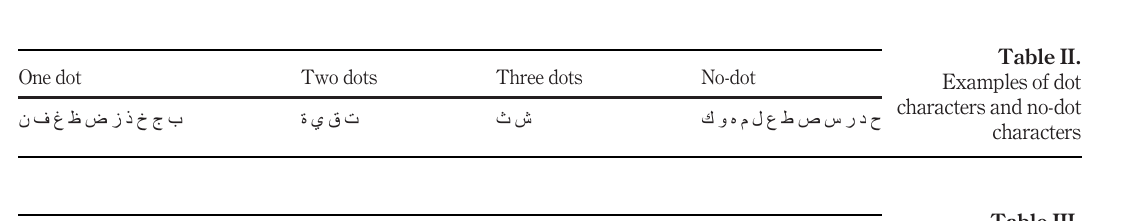
Table III. Examples of